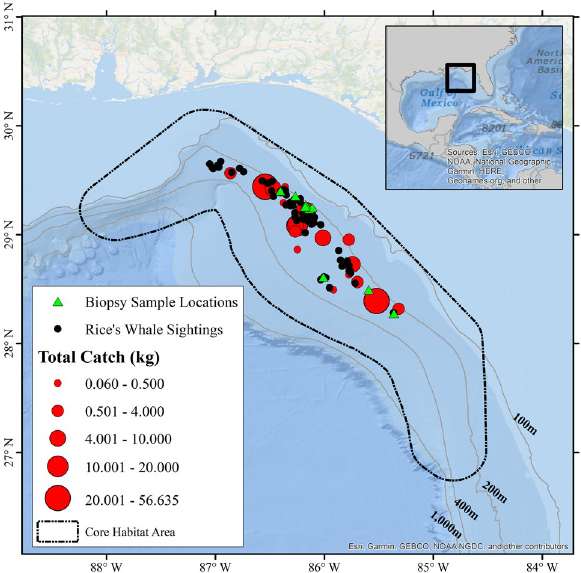
Figure 1. Trawl station locations and total catch (kg) in the Rice’s whale ( Balaenoptera ricei ) habitat in the northeastern Gulf of Mexico collected during July 2019. The locations of Rice’s whale observations during the same survey are indicated along with the core Rice’s whale habitat (Rosel and Garrison 42 ). Map created